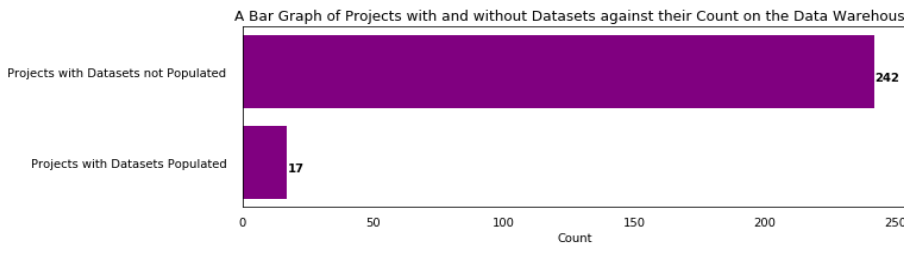
Figure 15. Data warehouse—projects with datasets